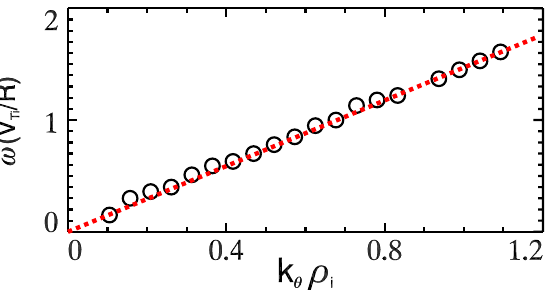
Figure 3. Frequency (depicted as circles) of the most linearly unstable modes as a function of poloidal wave number k θ ρ i . Red dash line shows the approximate linear relation ω